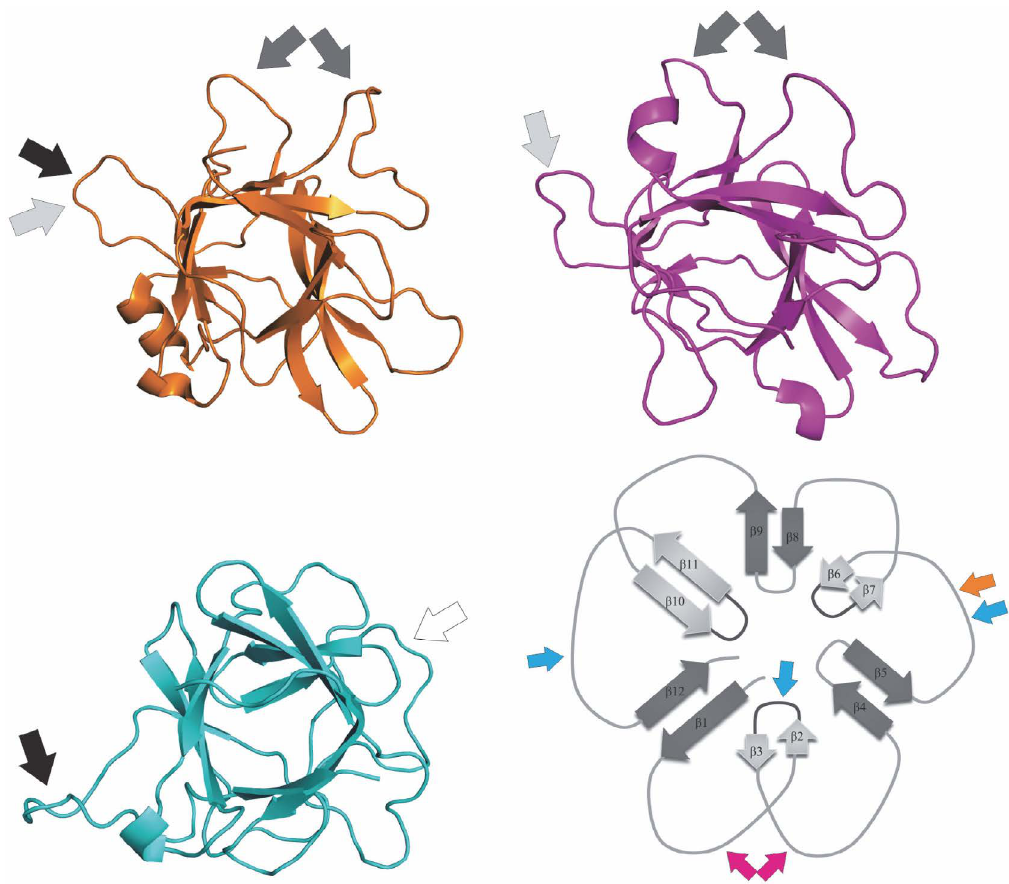
Figure 3. Structures of fungal cysteine protease inhibitors. Ribbon diagrams of the cysteine protease inhibitors macrocypin 1 (PDB code 3H6Q) in orange and clitocypin (PDB code 3H6S) in magenta are shown next to that of the serine protease inhibitor cospin (PDB code 3N0K9) in cyan. Loops with the following inhibitory reactive sites are marked with arrows: light grey arrows indicate asparaginyl protease/legumain inhibition, dark grey arrows indicate papain-like protease inhibition while white and black arrows indicate trypsin inhibition. A schematic representation of the β-trefoil fold loops involved in protease inhibition is shown bottom right. The protease family inhibited by individual loops of the β-trefoil fold in these fun- gal inhibitors is indicated by coloured arrows as follows: the asparaginyl protease/legumain with orange, papain-like proteases with magenta and trypsin with